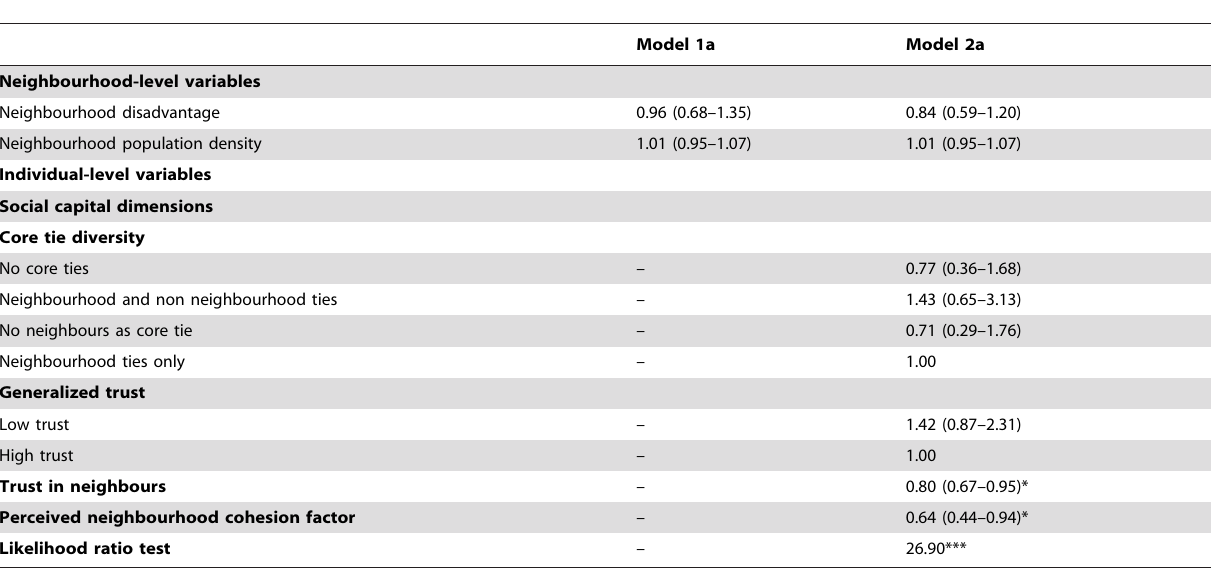
Table 1. Adjusted odds ratio and 95% confidence intervals from multilevel logistic regression analyses, MoNNET-HA Men, n= 912 (controlling for socio-demographic characteristics).